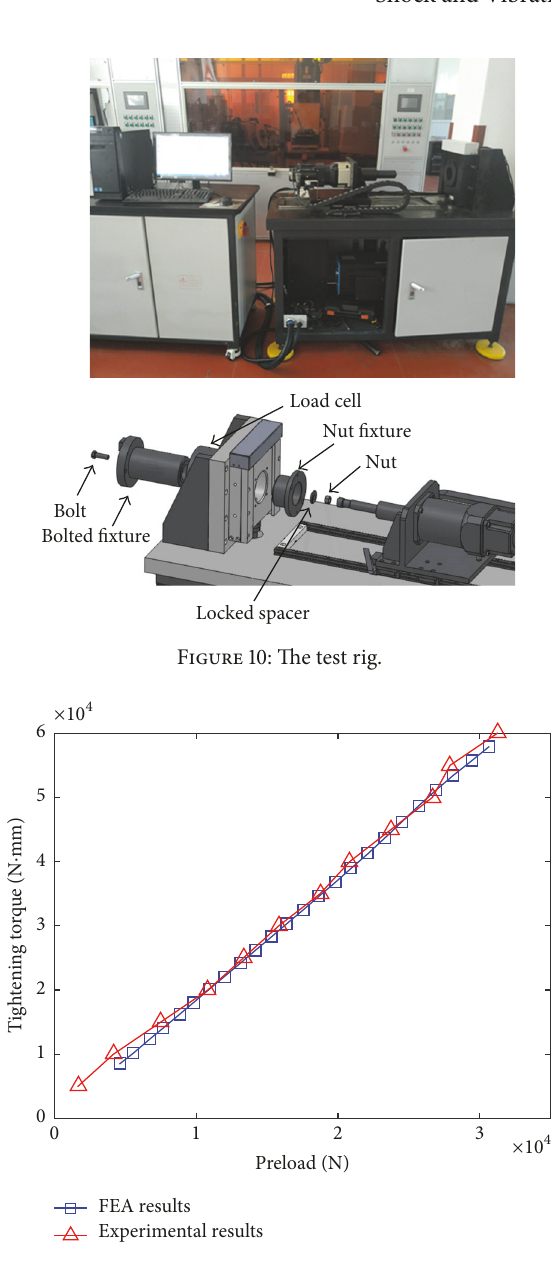
Figure 11: Comparison between the finite element method and the experimental